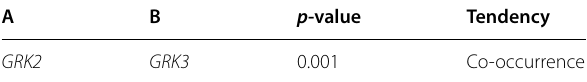
Table 2 Significant mutual exclusivity study of GRK family in colorectal cancer TCGA as analyzed by cBioportal p ‑value Tendency 0.001 Co-occurrence